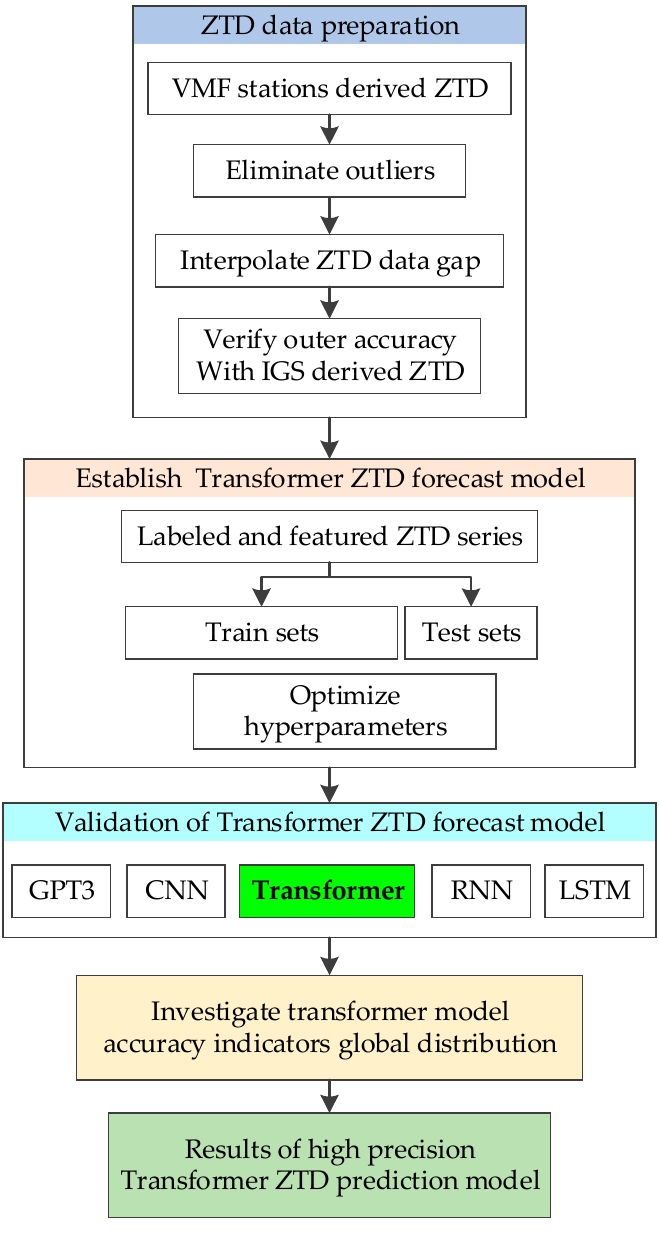
Figure 1. Transformer ZTD forecasting model structure designed in this study.